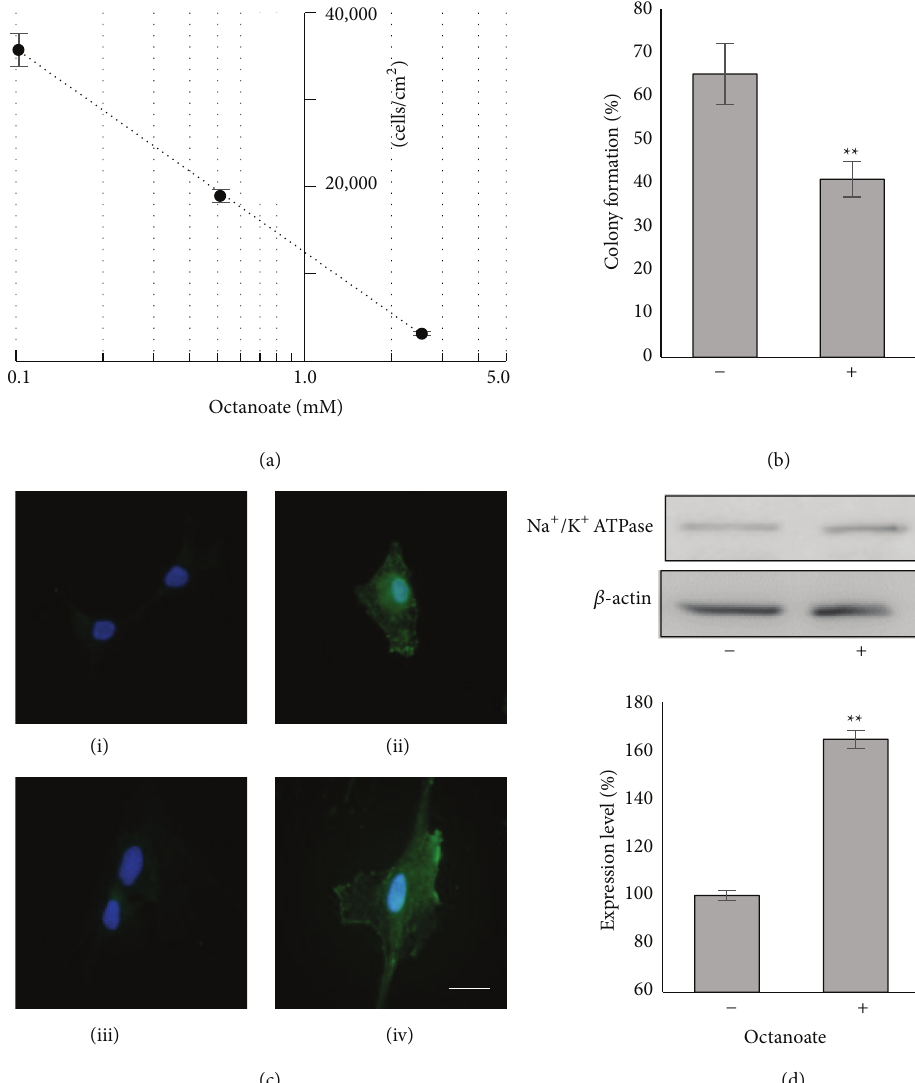
Figure 4: The effects of octanoate on MSCs. Growth of MSCs is inhibited at levels of octanoate in albumin products that are relevant to cell culture. Cells were grown for 3 days in PPRF-msc6 media with C-NPOF albumin and varying amounts of octanoate before counting. An inhibitory effect of 50% is seen at octanoate levels between 0.5 and 0.6 mM (a). Colony formation is reduced to about 40% of cells grown in PPRF-msc6 with C-NPOF albumin, 0.67 mM octanoate for 4 passages (b). MSCs grown for 4 passages in PPRF-msc6 with C-NPOF albumin ((i), (ii)) and C-NPOF albumin with octanoate ((iii), (iv)) express Na + /K + ATPase. Panels (ii) and (iv) contain mouse anti-Na + /K + ATPase 1: 50 while all panels contain secondary goat anti-mouse antibody coupled to Alexa Fluor 488 (green). Nuclei are stained blue with Hoechst 33258. Bar equals 20 𝜇 m (c). Quantitation of Na + /K + ATPase expression in MSCs. Cells were grown for four passages as in (c) before being lysed in RIPA buffer and analyzed by Western blotting. Bands were quantitated using Image-J and values normalized against 𝛽 -actin. Experiments were performed in duplicate (d). ** indicates a 𝑃 < 0.01